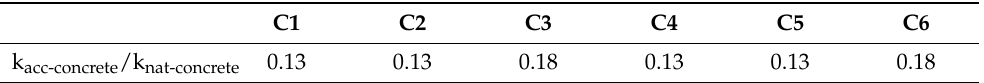
Table 19. Ratio of carbonation coefficient (k acc-concrete /k nat-concrete ) for strength classes C25/30 and C30/37 of specimens exposed in Xanthi and in the carbonation